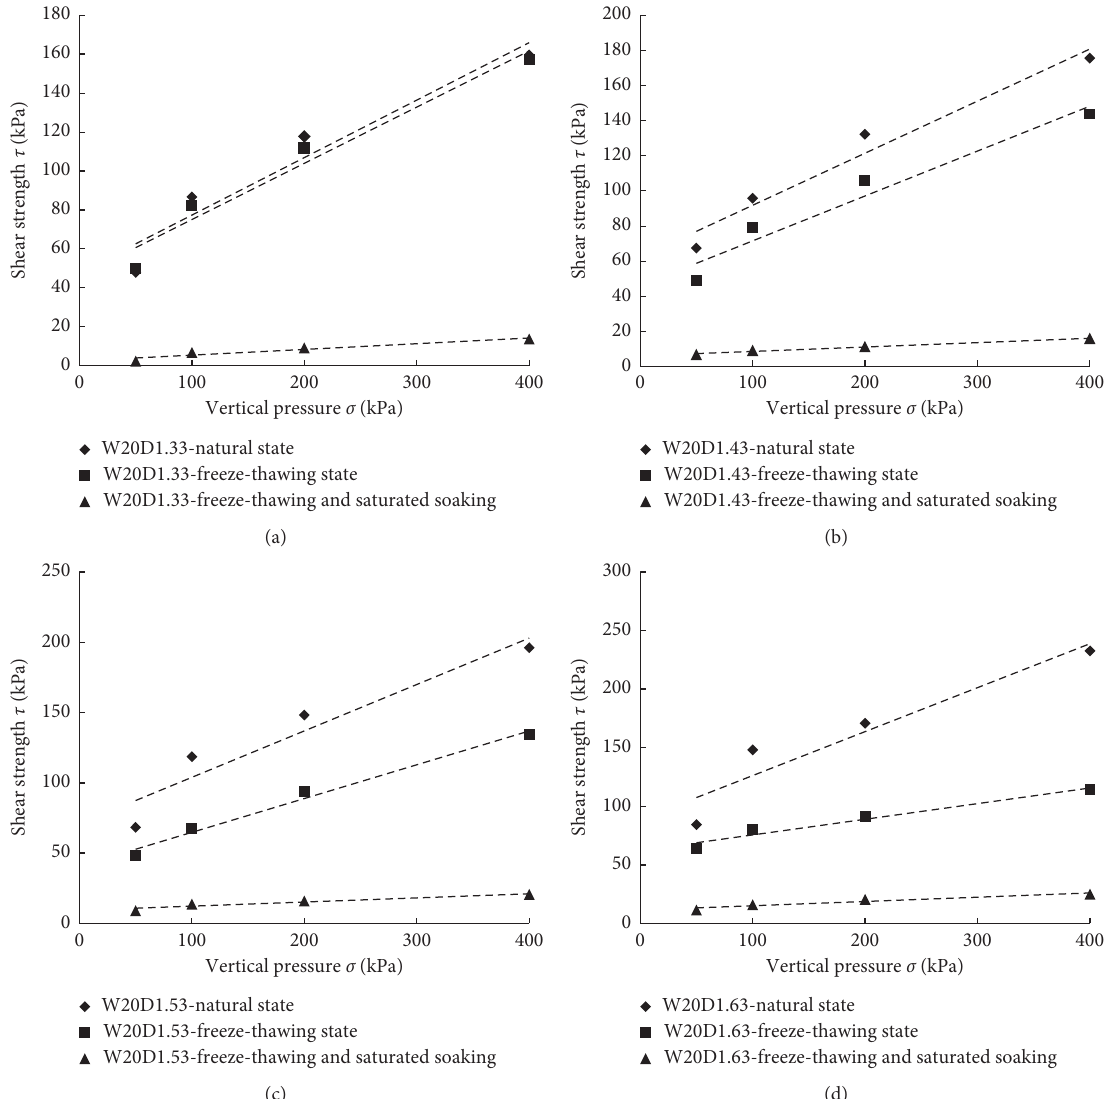
Figure 4: Shear strength of soil samples of different initial dry densities for various test conditions. (a) W20D1.33 sample, (b) W20D1.43 sample, (c) W20D1.53 sample, and (d) W20D1.63